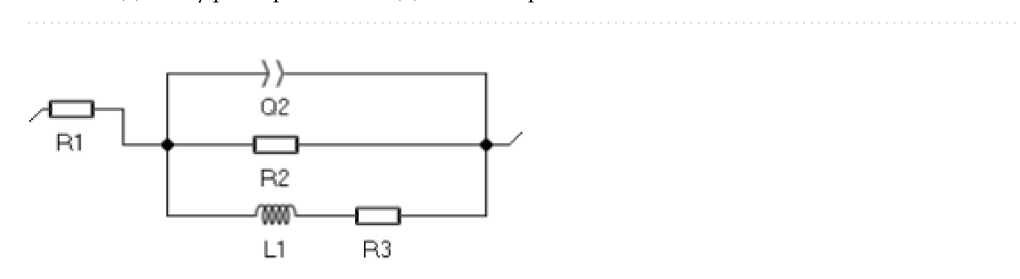
Figure 15. Results of electrochemical impedance spectroscopy (EIS) for uncoated and coated LAE442 alloy substrate: ( a ) the Nyquist representation, ( b ) the Bode representation.